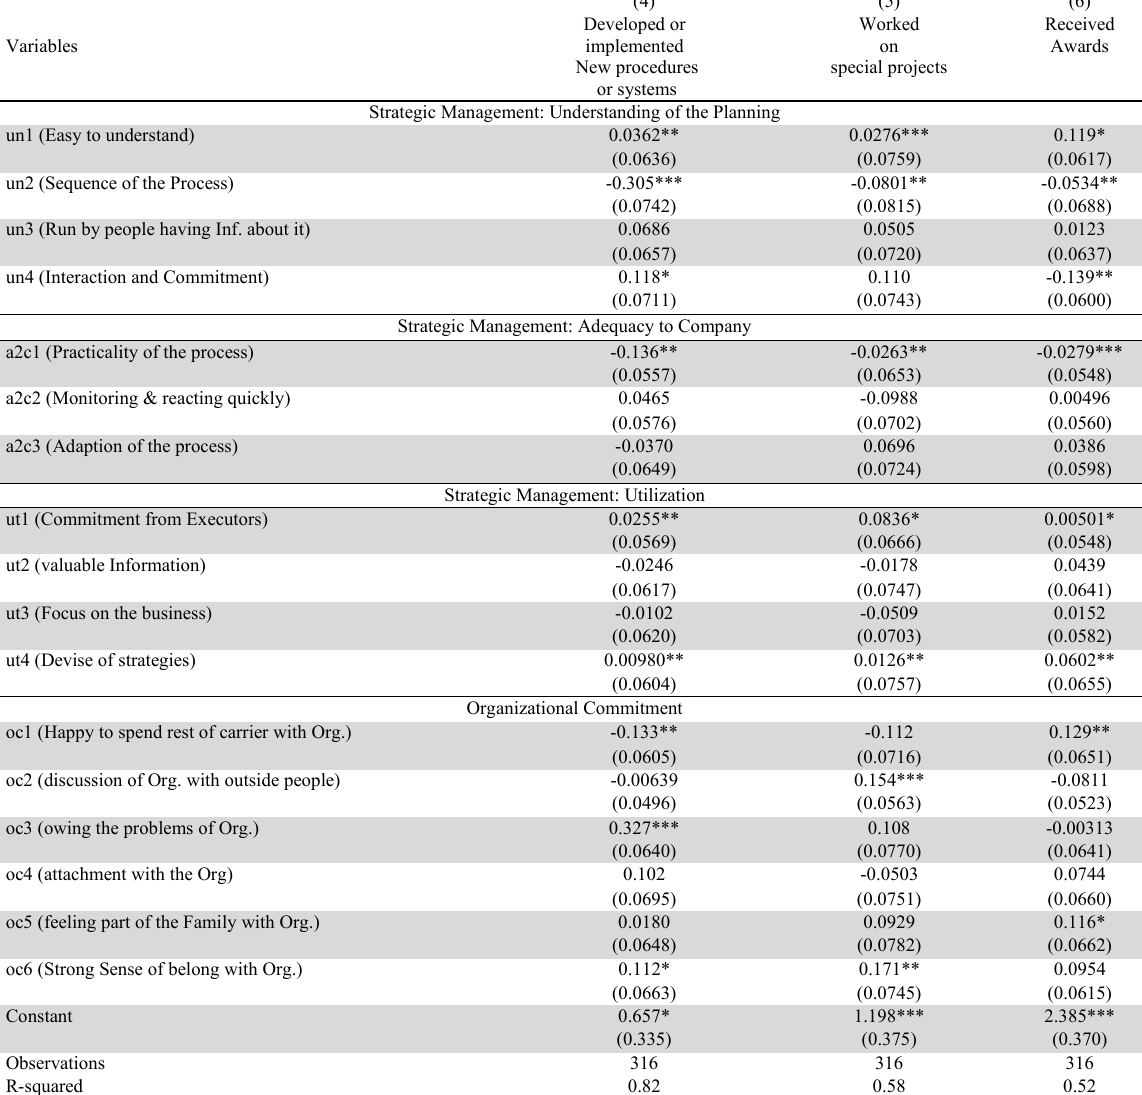
Impact of Strategic Management and Organizational Commitment